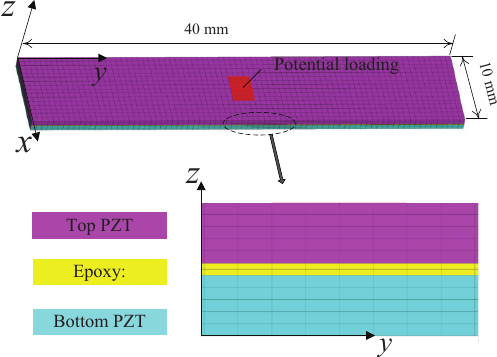
Figure 9. Finite element mesh of the piezoelectric bimorph sensor. When a normal loading of 1 N is applied to the sensor, the distribution of electric potential in the bottom and top piezoelectric element is plotted in Figure 10a. The simulation results are basically inconsistent with the theoretical analysis. The bottom PZT generates an electric potential difference between the two opposing faces in direction z . The top PZT also exists electric potential variation but only near the loading area, which does not affect the electric potential difference between the two opposing faces in direction x . When a tangential loading of 1 N is applied to the sensor, the distribution of electric potential for two piezoelectric elements is plotted in Figure 10b. The top PZT generates an obvious electric potential difference between the two opposing faces in direction x , and there is an electric potential concentration near the loading area. Although the bottom PZT generates electric potential change near the loading area, the electric potential between its up and down surfaces remains the same, i.e., the tangential loading does not affect the output voltage of the bottom PZT. It can be seen that as long as the loading position avoids the edge of the sensor, the output voltage of the bottom PZT only relates to the normal loading acting on the sensor surface and the output voltage of the top PZT only relates to the tangential loading.